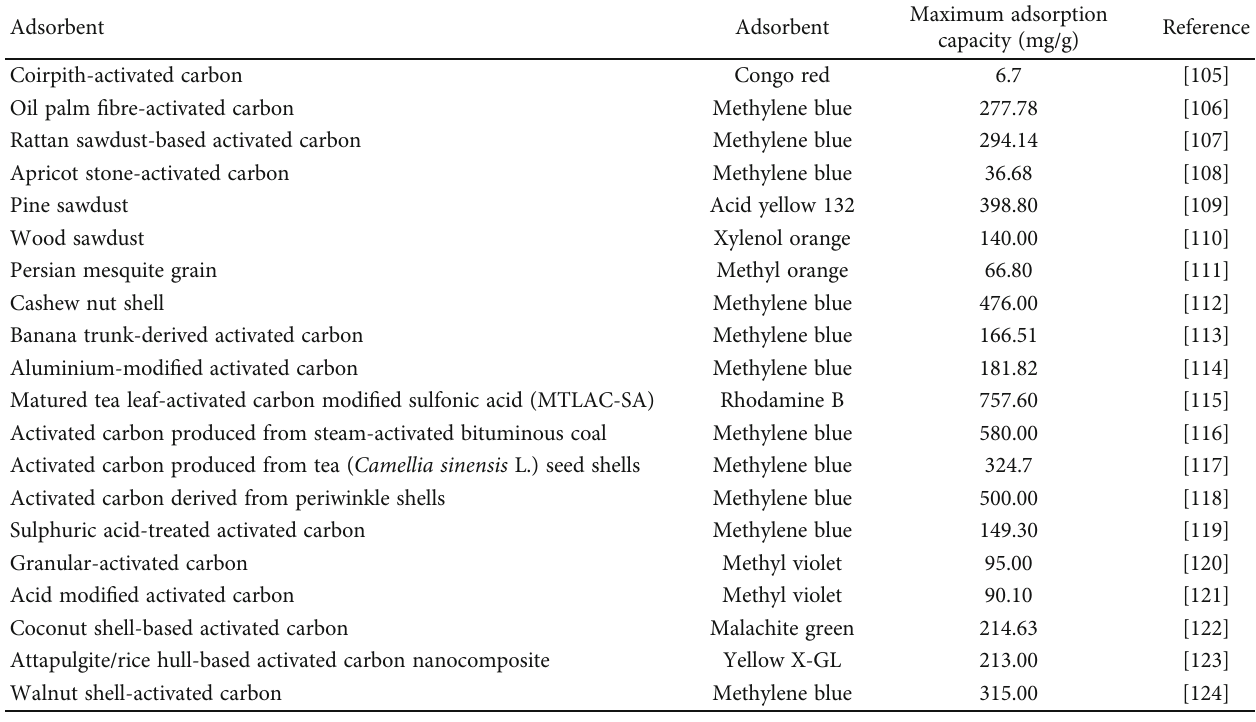
Table 6: Removal of dyes by various AC-based